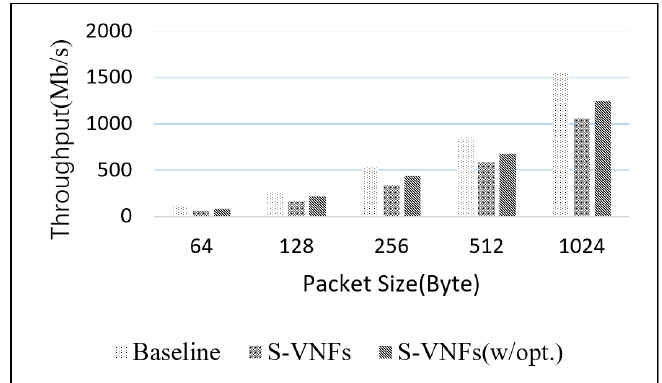
Figure 6. System throughput at different packet sizes.